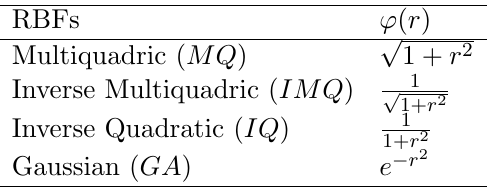
Table 1. Radial basis functions. RBFs ϕ ( r ) Multiquadric ( MQ